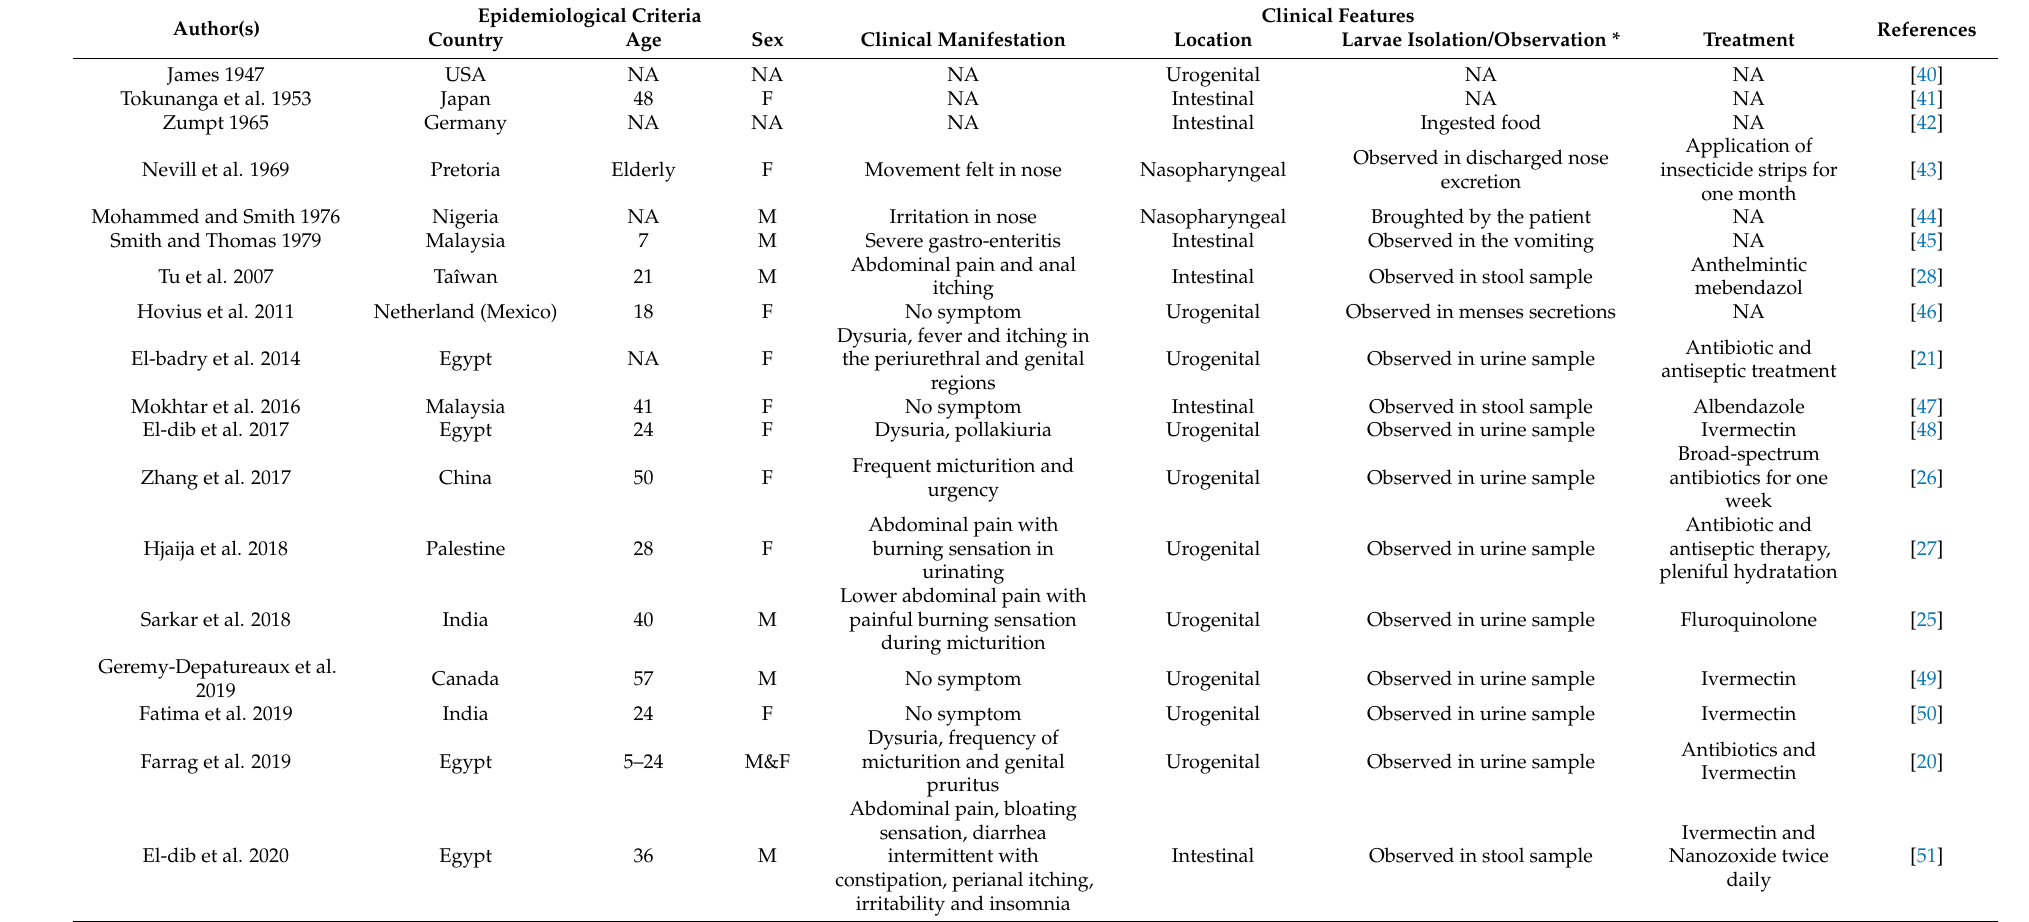
Table 1. Epidemiological criteria and clinical features of the myiasis reported to be caused by Clogmia albipunctata in the